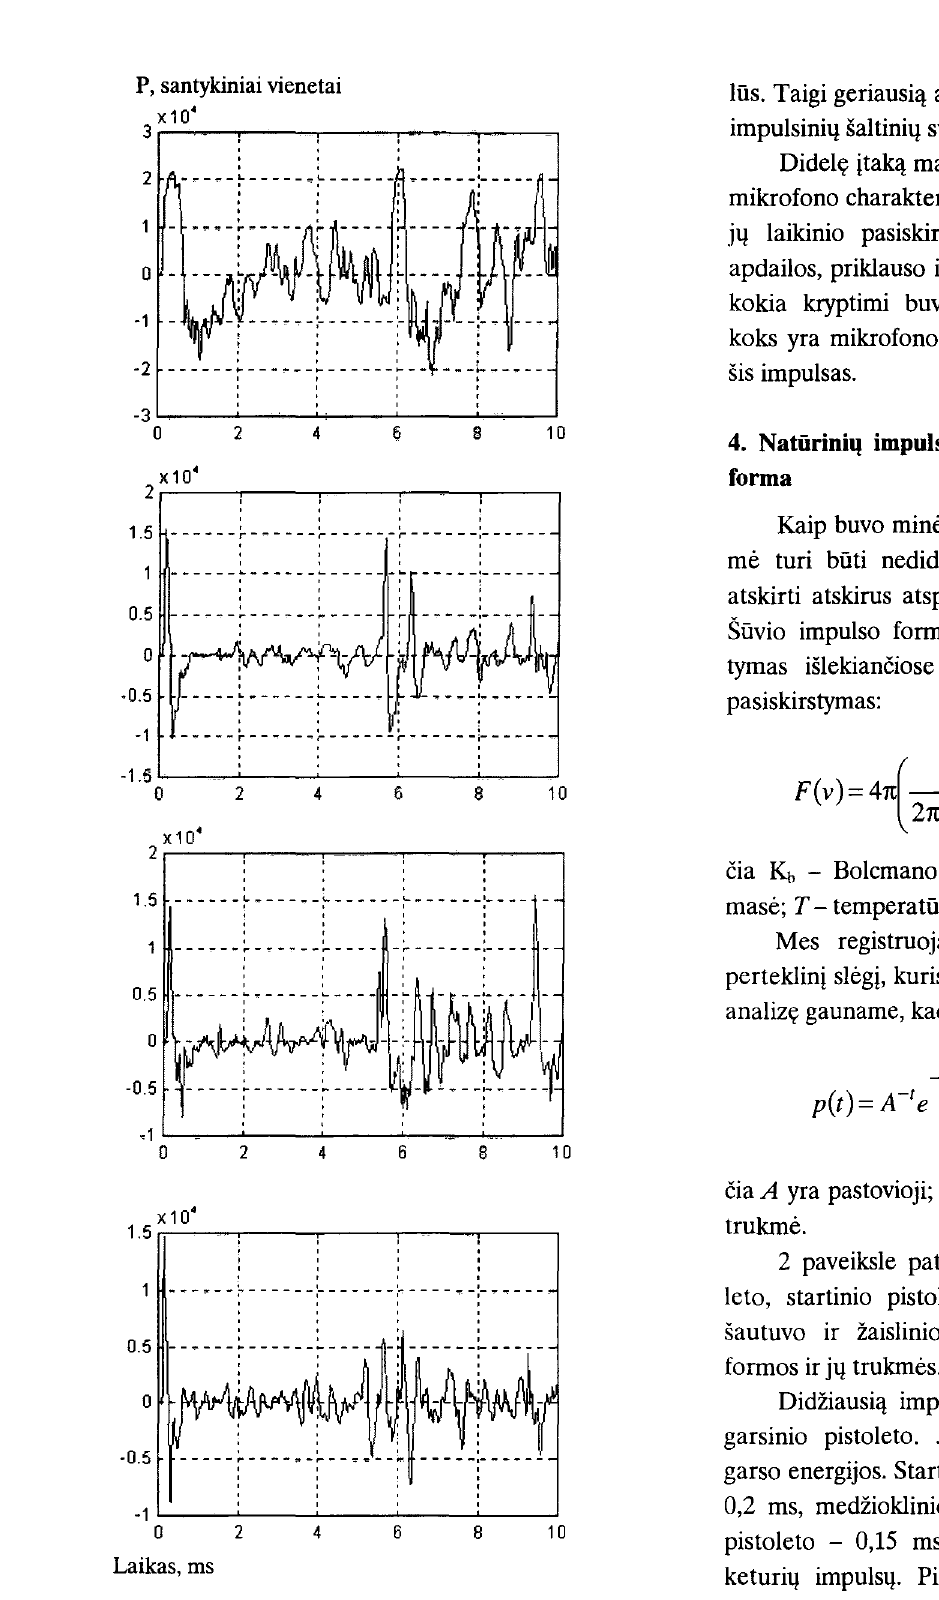
Laikas, ms 1 pav. Garso atspindziq struktiira, gaunama suzadinant garso laukq skirtingais impulsais. IS virsaus: 9-to kalibro garsinis pistoletas; startinis pistoletas; 16-to kalibro medzioklinis sautuvas; zaislinis pistoletas Fig 1. Sound reflection structure obtained exciting sound field with diferent pulses. Top · 9-calibre sound pistole; start pistole; 16-calibre hunting gun; toy